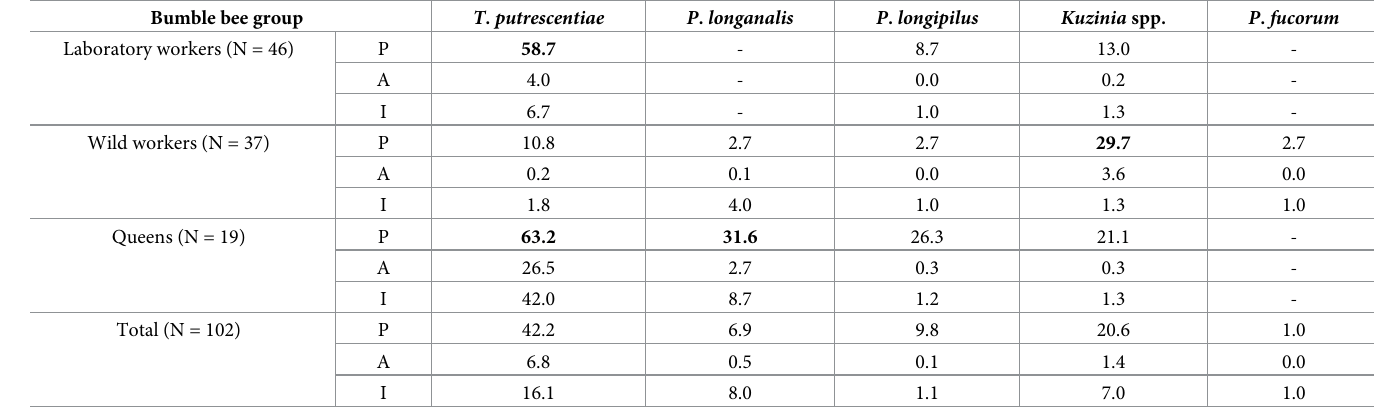
The highest prevalence values are shown in black.